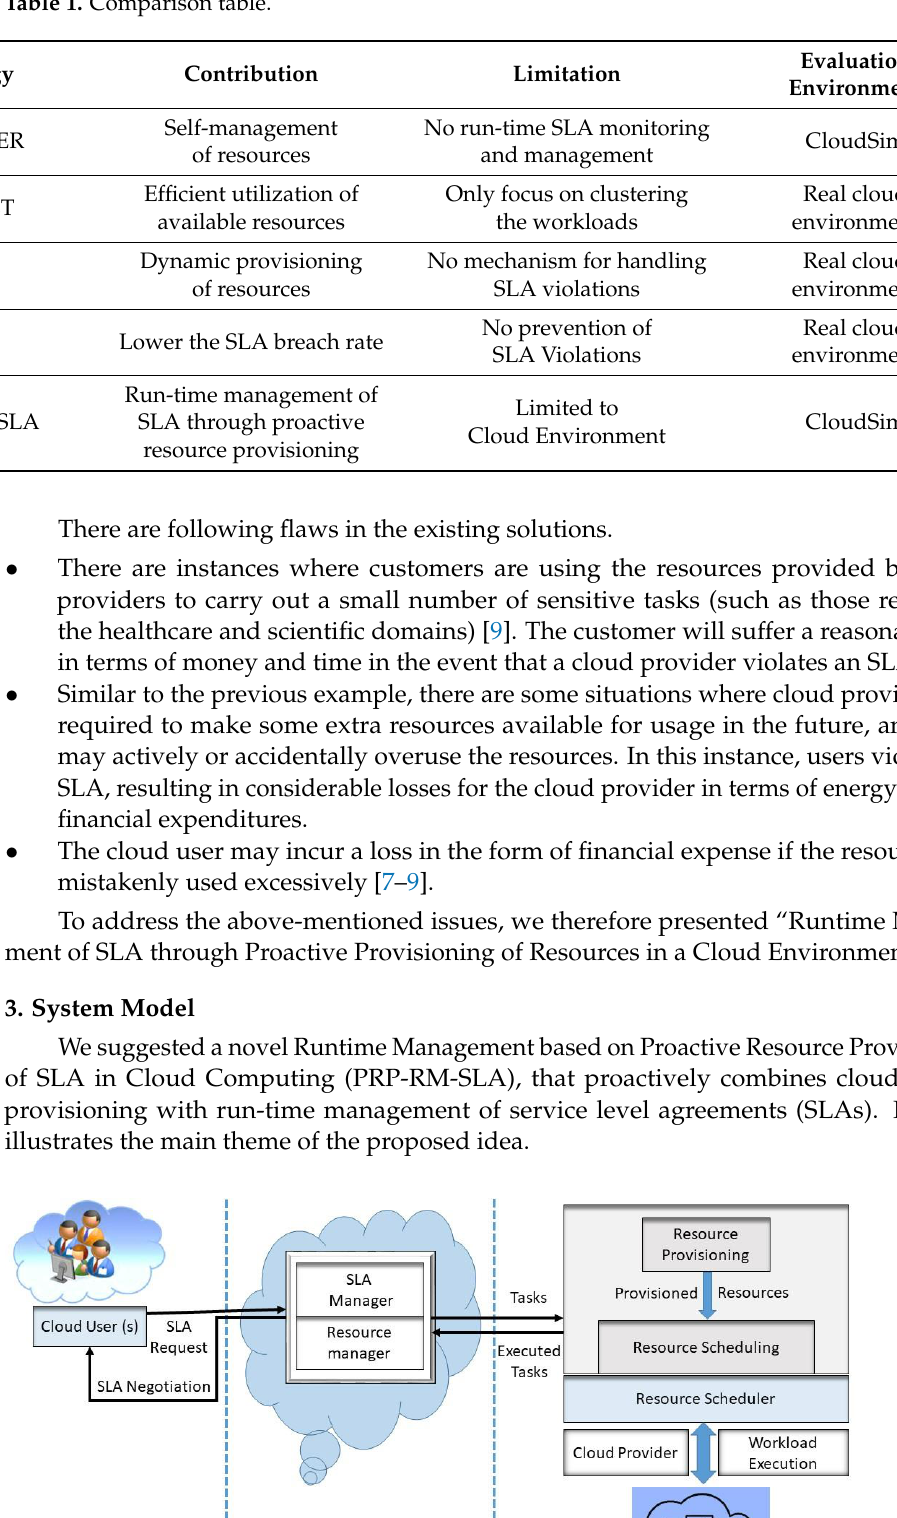
Table 1. Comparison table.